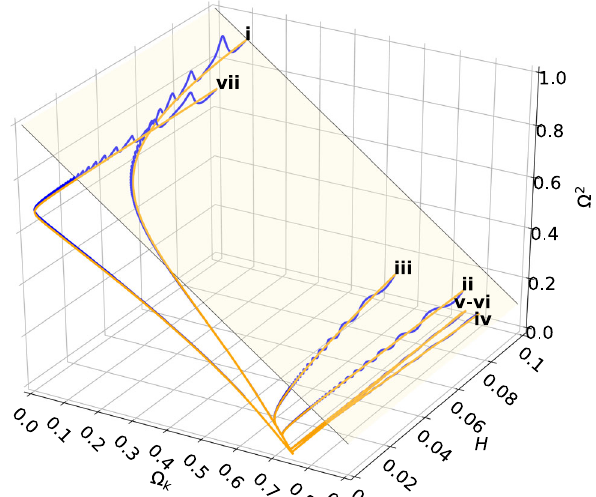
Fig. 16 Some solutions of the full system (46) (blue) and time-averaged system (78) (orange) for the LRS Bianchi III metric when γ = 1, in the projection Σ = 0. We have used for both systems initial data sets presented in the Table